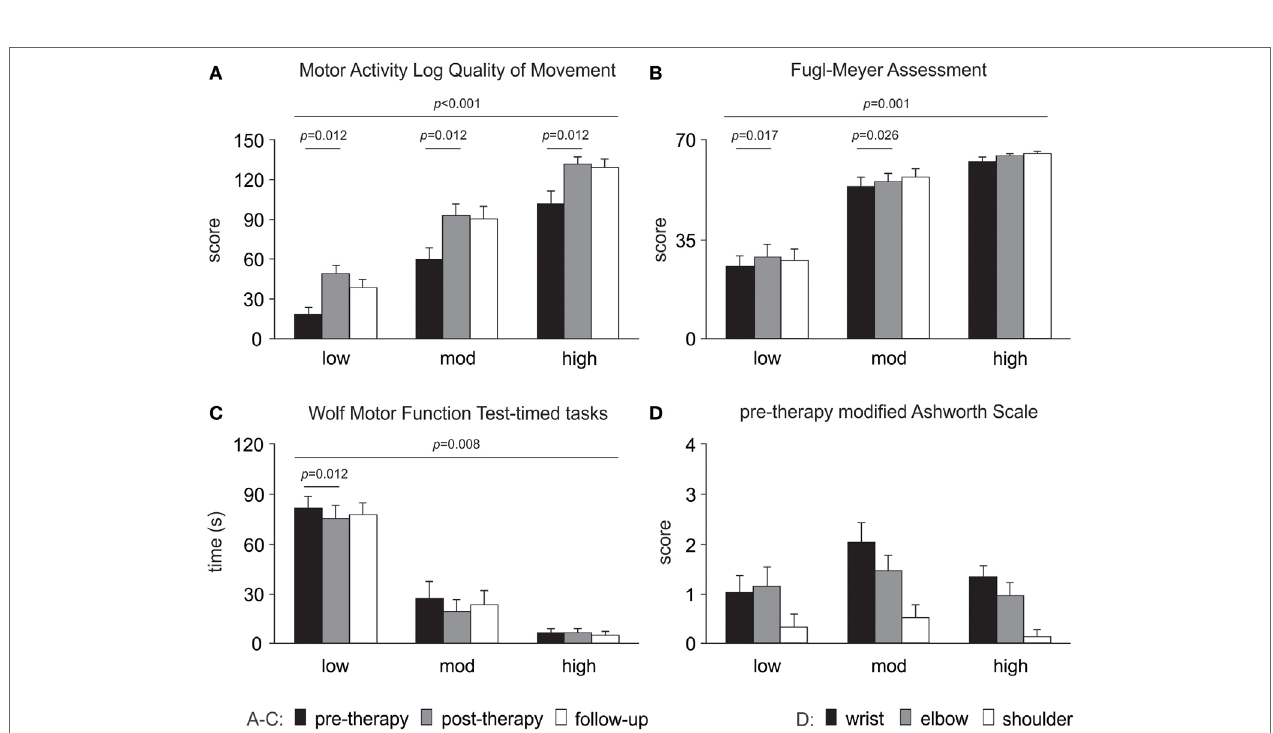
Figure 3 | Pooled data showing changes in electromyography over time. Changes are presented as mean ± SE for the area under the curve according to the level of poststroke motor-function. Significant changes in movement duration (md) are also